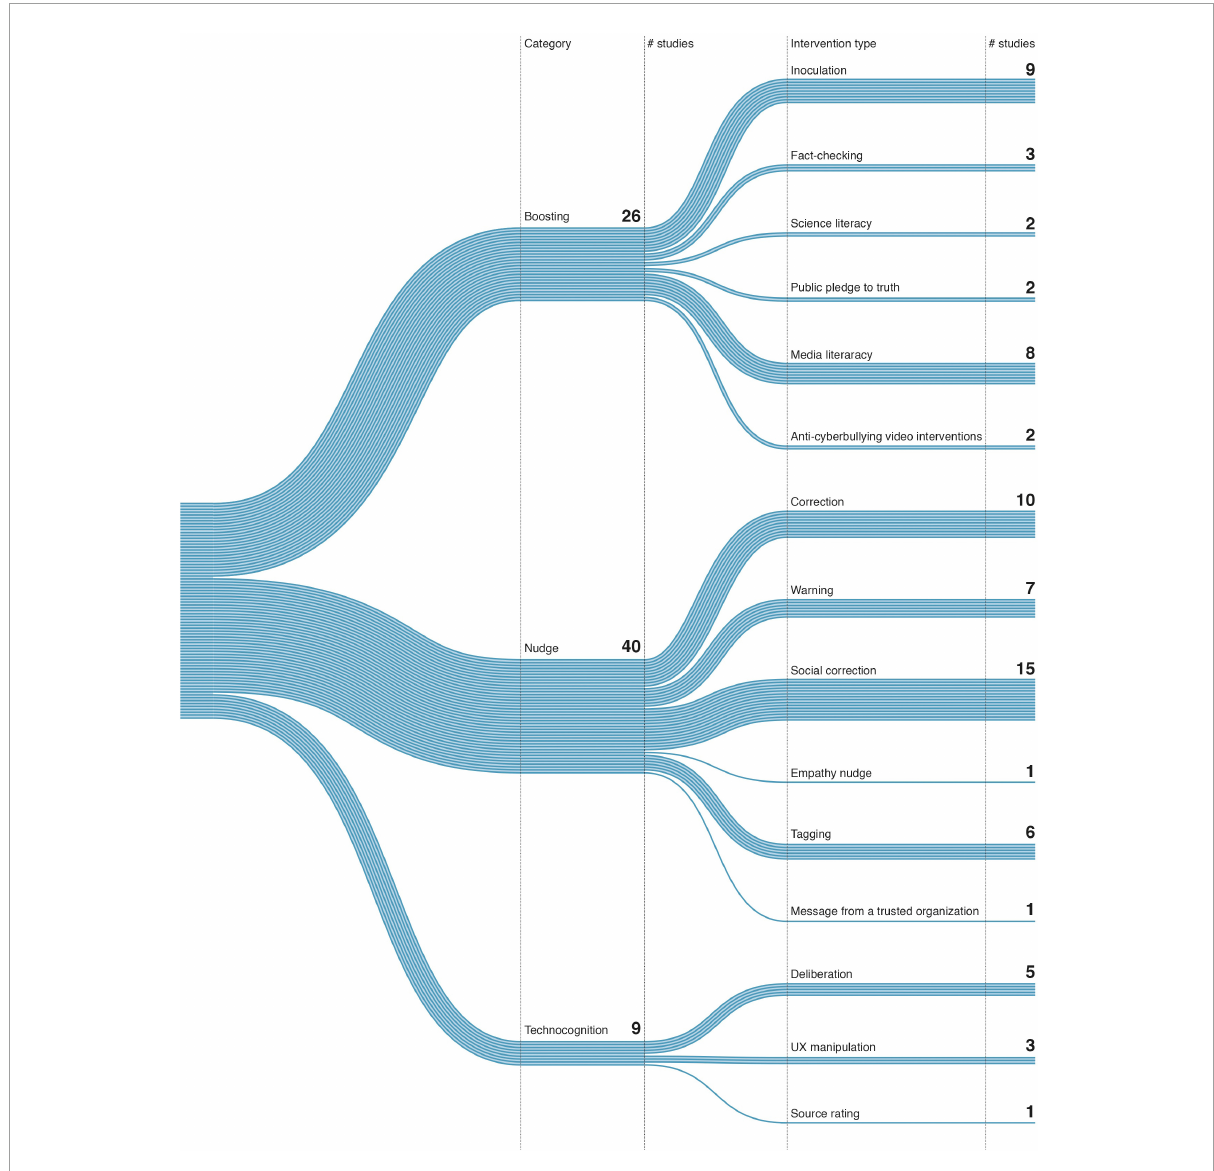
FIGURE2 Misinformation psychological interventions typology based on Kozyreva et al. (38).